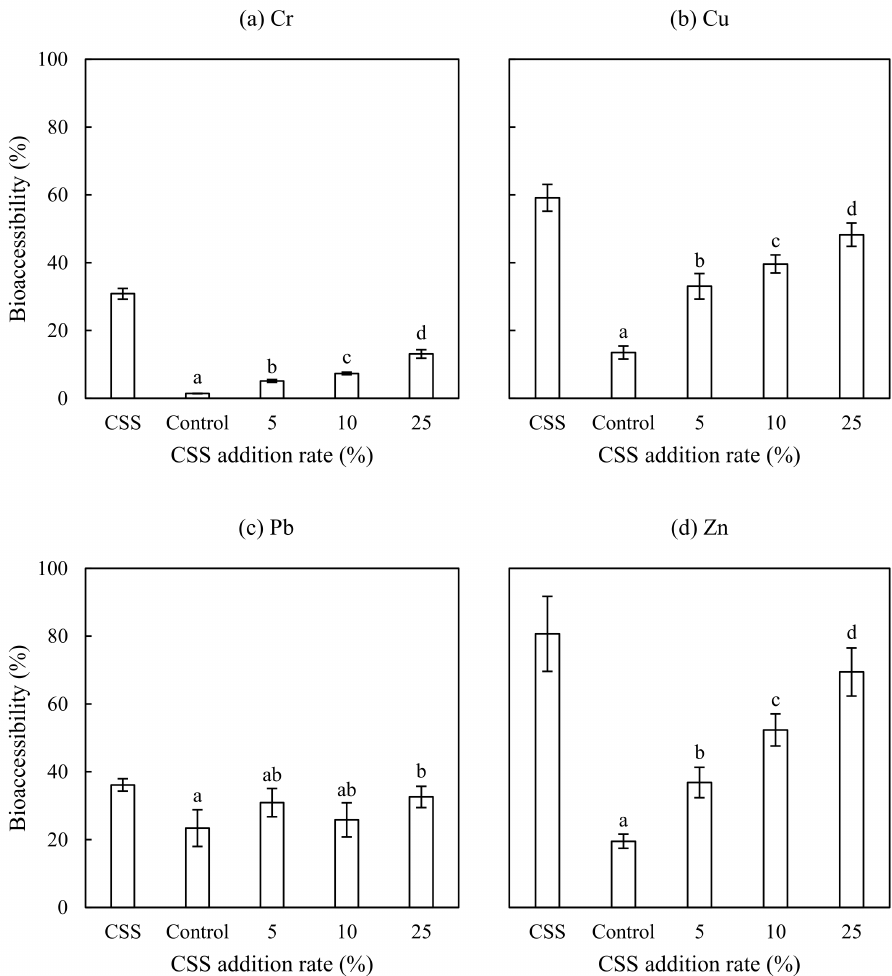
Figure 3. Heavy metal bioaccessibility in the CSS, control, and amended soil. For a given element, the columns labelled with the same letter were not significantly different at a significance level of p < 0.05 by the LSD test. The error bars represent one standard deviation ( n = 3). ( a ) Cr bioaccessibility in the CSS, control, and amended soil; ( b ) Cu bioaccessibility in the CSS, control, and amended